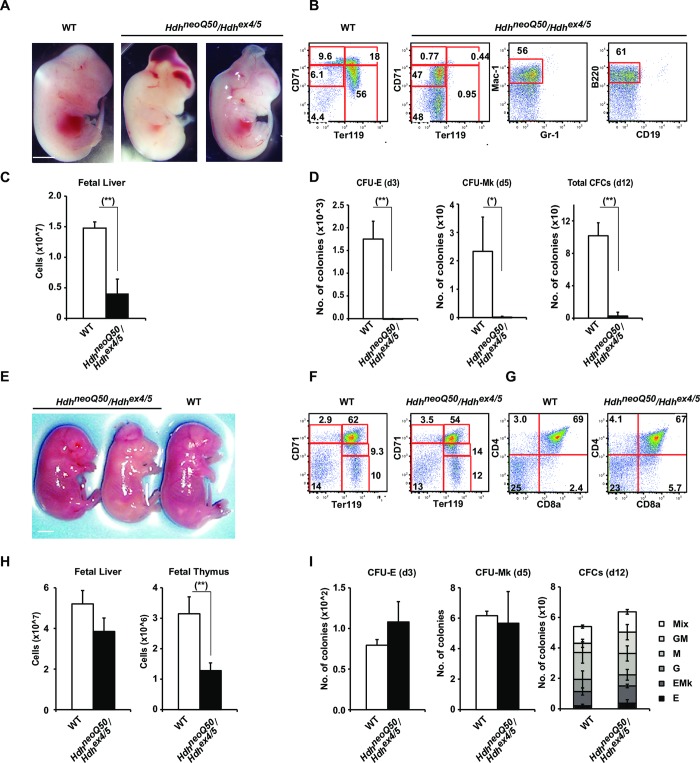
Hematopoietic defects in HdhneoQ50/Hdhex4/5 hypomorphic embryos.A, E) Representative images of the appearance of fetal liver in wild-type (WT) and HdhneoQ50/Hdhex4/5 embryos displaying dome shaped cranium and exencephaly at E14.5 and E18.5. Scale bars: 1 mm. B, F, G) Representative FACS profiles of fetal liver hematopoiesis in wild-type (WT) and HdhneoQ50/Hdhex4/5 embryos at E14.5 and E18.5, respectively. Erythroblasts were gated into fractions defined by CD71 and Ter119 expression, displaying transient anemia at E14.5, rescued by E18.5. Myeloid cells and B cell progenitors were identified as Mac-1+Gr-1– and B220+CD19–, respectively at E14.5 fetal liver T cells were stained with CD4 and CD8a cell surface markers. C, H) Bar graphs summarizing the absolute cell numbers of whole fetal liver at E14.5 and E18.5 for wild-type (WT) and HdhneoQ50/Hdhex4/5 embryos, displaying transient defects in hematopoiesis at E14.5. At E14.5, WT embryos N = 5, HdhneoQ50/Hdhex4/5 embryos N = 3. At E18.5, WT embryos N = 3, HdhneoQ50/Hdhex4/5 embryos N = 3. Error bars represent standard deviations from the mean. (**) and (*) indicate significant P value, with (**) P<0.01 and (*) P<0.05, respectively. D, I) Bar graphs summarizing the results of colony assays on wild-type (WT) and HdhneoQ50/Hdhex4/5 fetal liver indicate a dramatic depletion of erythroid (CFU-E), Megakaryocytes (CFU-Mk) and total colony forming cells (Total CFCs) in E14.5 HdhneoQ50/Hdhex4/5 fetal liver. By E 18.5, the phenotype was completely rescued and no difference in erythroid (CFU-E and BFU-E (E)), megakaryocyte (CFU-Mk) myeloid (G, M, GM), erythroid-megakaryocyte (E/Mk) and multi-lineage mixed (Mix) colony forming cells was observed. Error bars represent standard deviations from the mean. d3, day3; d5, day5, d12, day12.